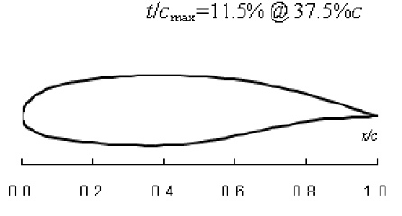
Figure 2. Supercritical airfoil.